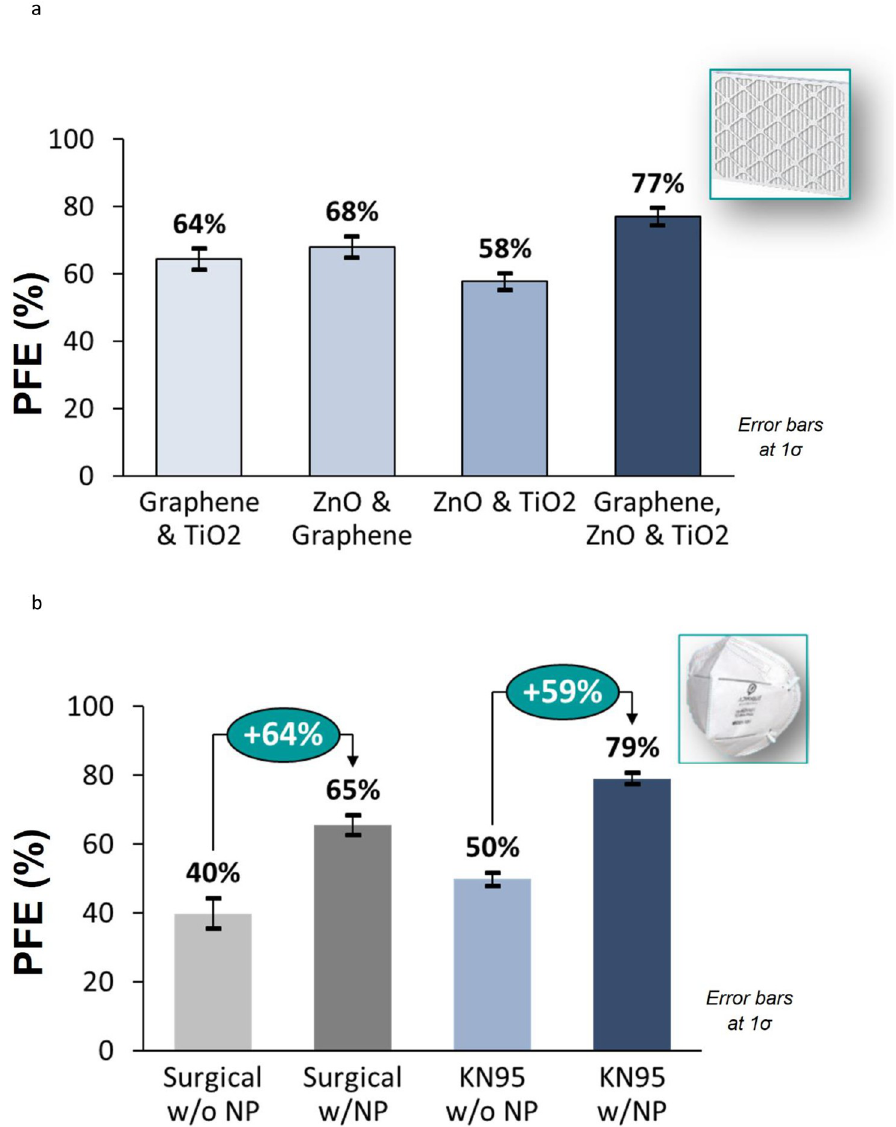
Fig 5. a. PFE on HVAC filters improved by optimization of different nanoparticle coatings. b. Nanoparticle coatings on surgical and KN95 masks improve their PFE by